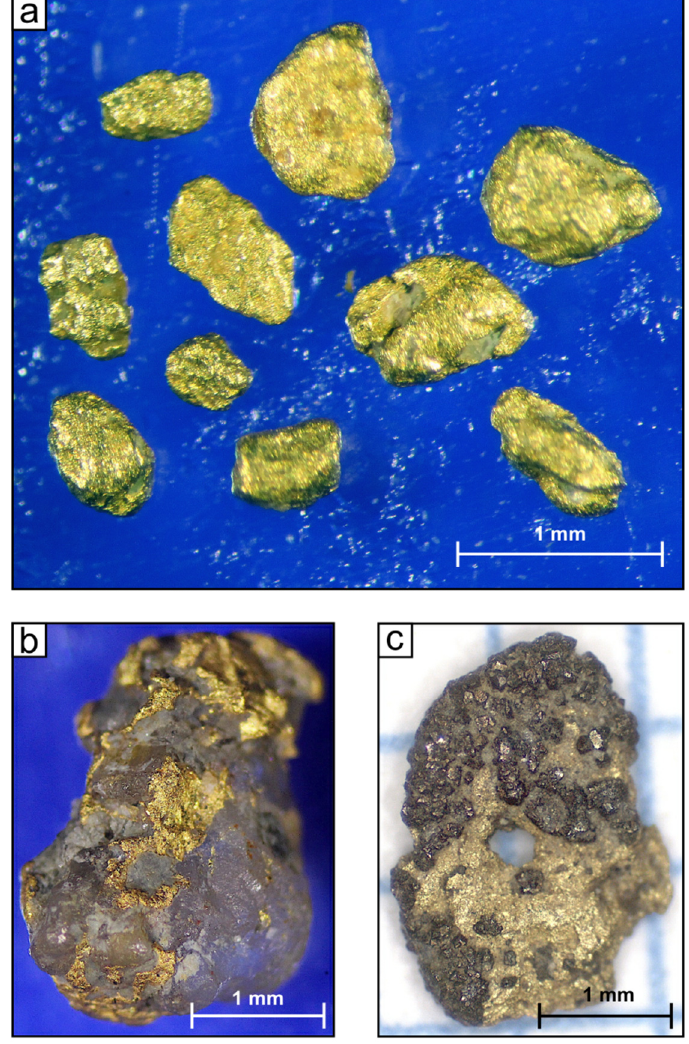
Figure 4. Placer gold particles from the Pureo area. ( a ) Gold particles under binocular microscope. ( b ) Quartz pebble with inclusions of native gold, which has not been released from its quartz matrix, probably from an eroded vein. ( c ) Pyrite coverage over particle surface.